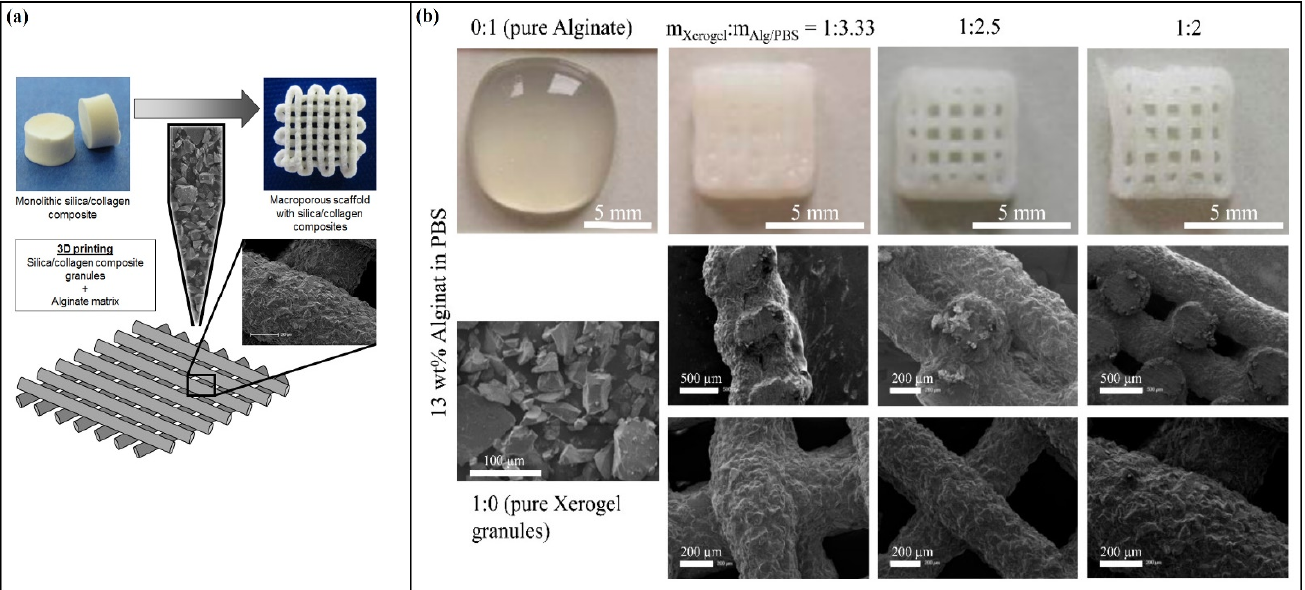
Figure 5. Illustration of 3D plotting approach of silica–collagen hybrid xerogel granules in an algi- nate matrix; (a) the fabrication approach, and (b) photographs and SEM images of a different ratio matrix; ( a ) the fabrication approach, and ( b ) photographs and SEM images of a different ratio of of xerogels. Adapted from Rößler et al. [79] xerogels. Adapted from Rößler et al.